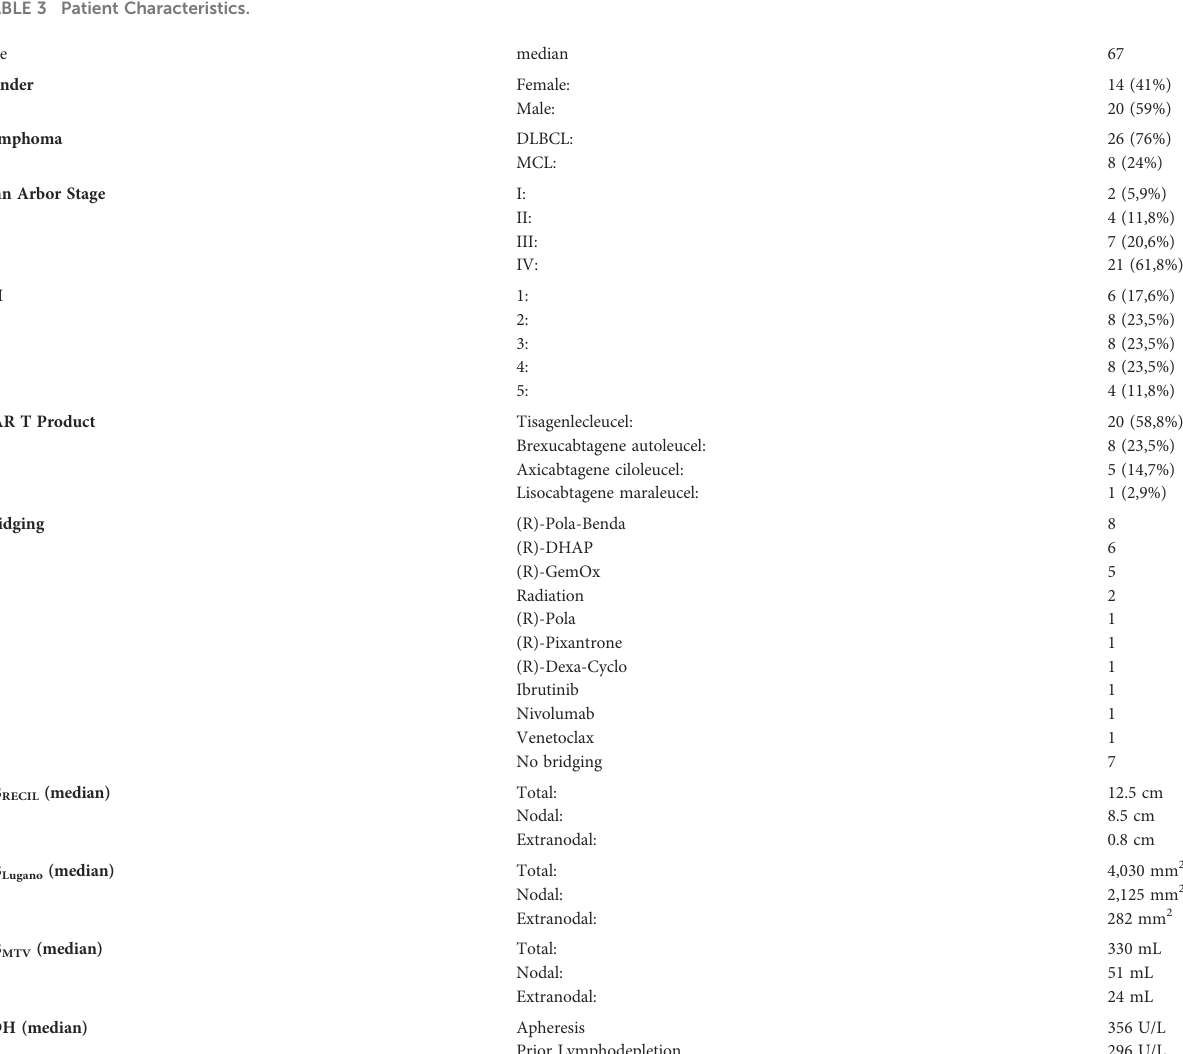
TABLE 3 Patient